Question: What type of chart is this?
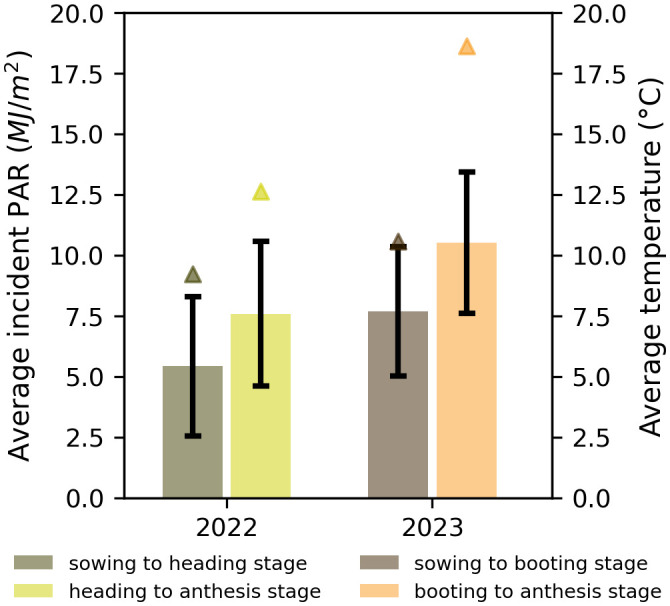
Answer: bar